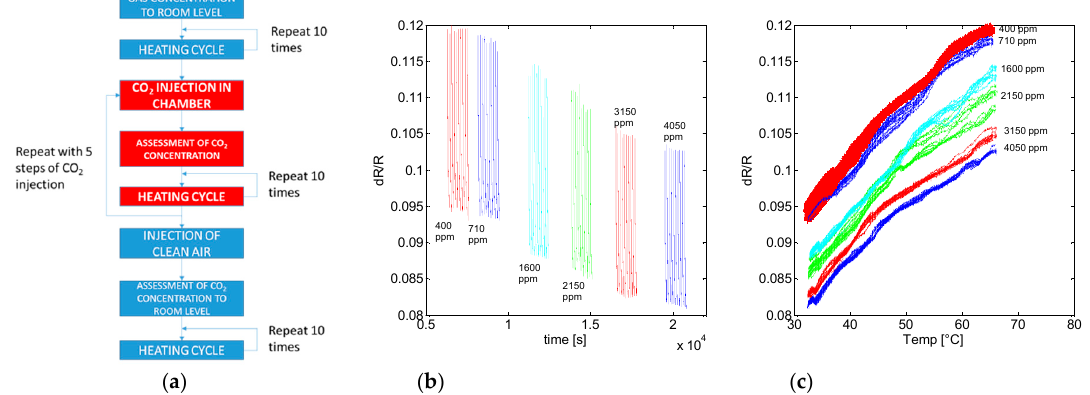
Figure 3. ( a ) The flow diagram of the measurement protocol implemented for the lab scale prototype of the Inkjet Printed CO 2 sensor; ( b ) Response of the gas sensor during the heating cycles for different values of the CO 2 concentration; ( c ) The sensor behavior as a function of the heating temperatures and the CO 2 concentration.